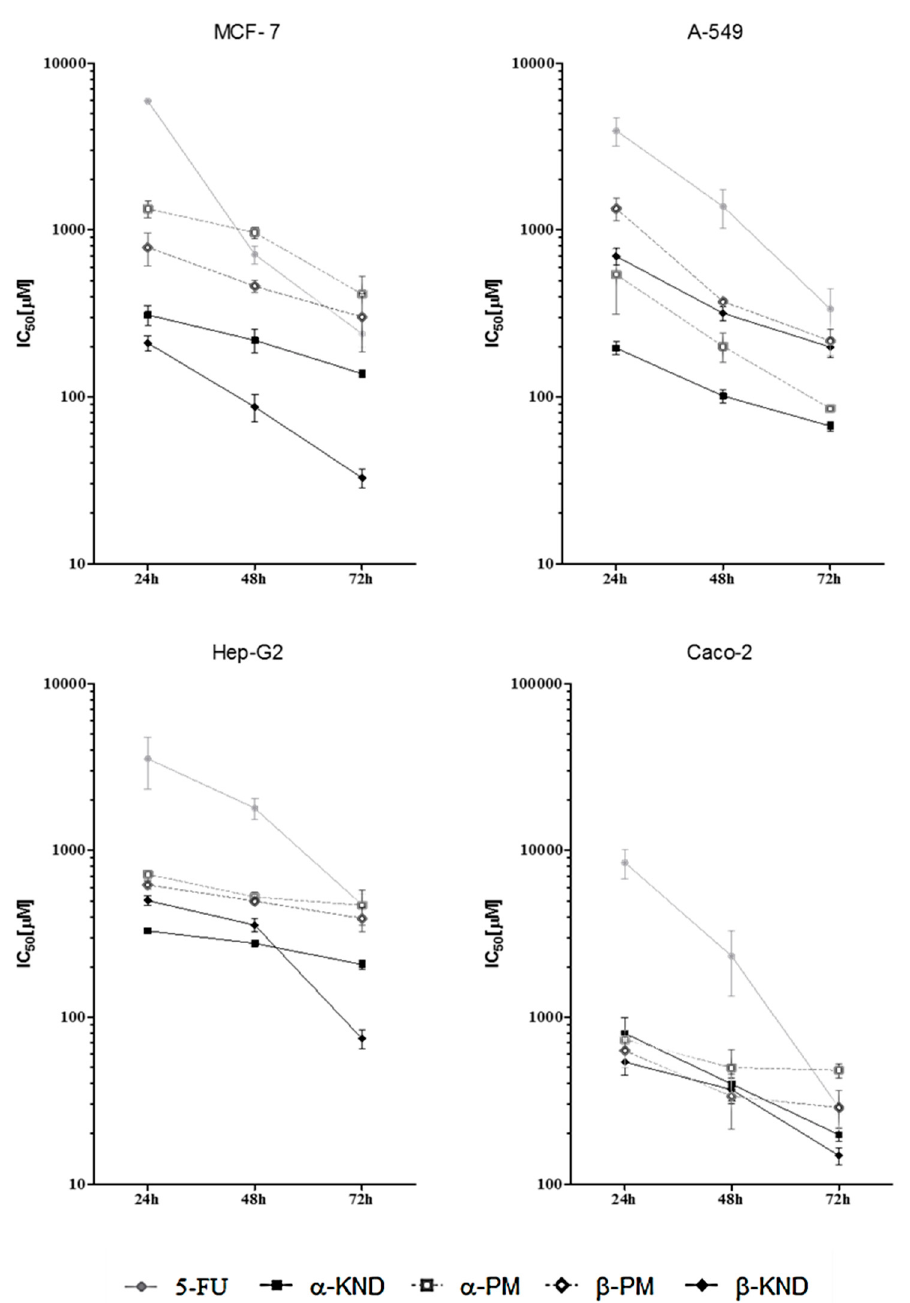
Figure 10. Cytotoxicity expressed as statistically estimated IC 50 values ( µ M) of 5-FU, α -KND, β -KND, α -PM, and β -PM on the four selected cell lines at 24, 48, and 72 h. Bars represent standard error.